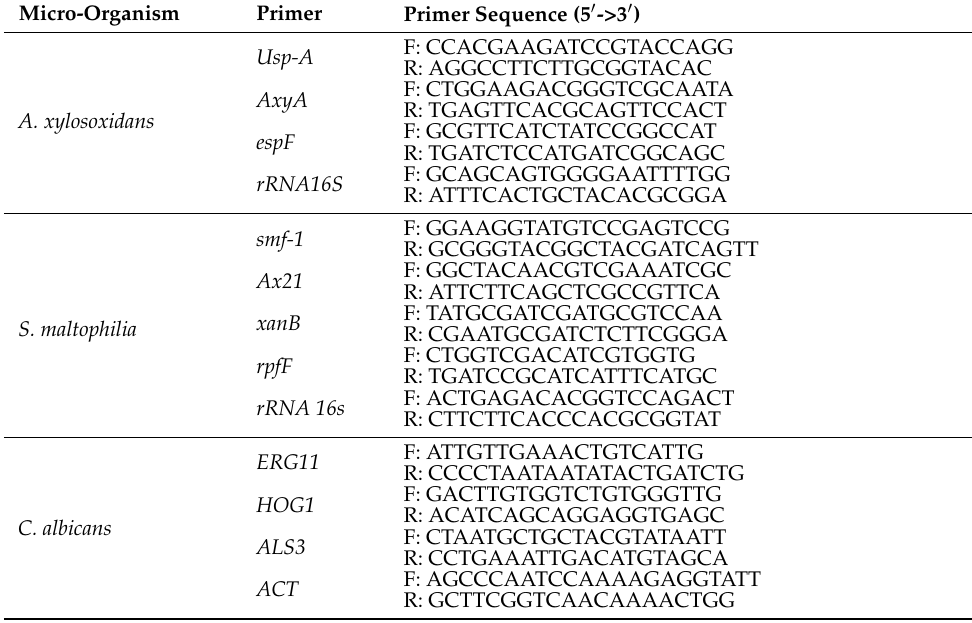
Table 4. Primer sequences used in this